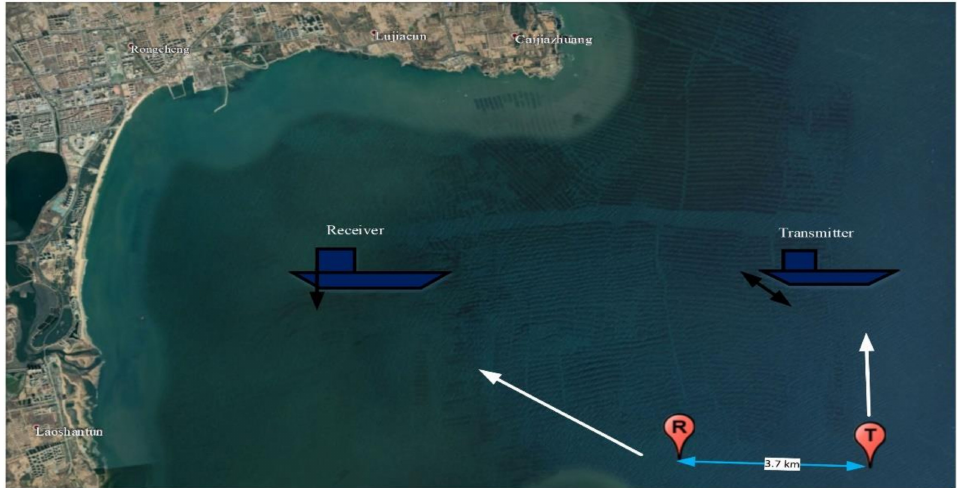
Figure 12. Schematic diagram of trial scenario. The receiving end (point R) is fixed, the transmitting ship (point T) moves with the ocean current at a speed of 0–3 m/s, and the distance is 3.7–4.0 km.